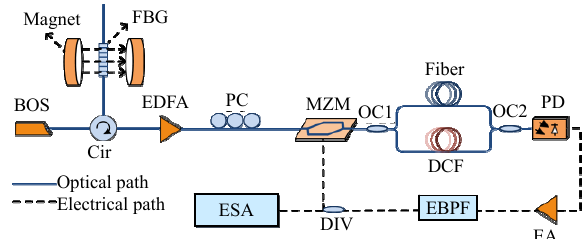
Fig. 1 Experimental system based on a dual-loop optoelectronic oscillator used for magnetic field